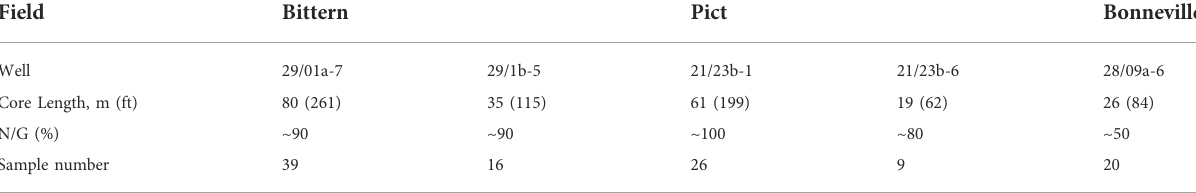
TABLE 2 Details of the cores sampled for this study. N/G stands for net (sandstone) to gross